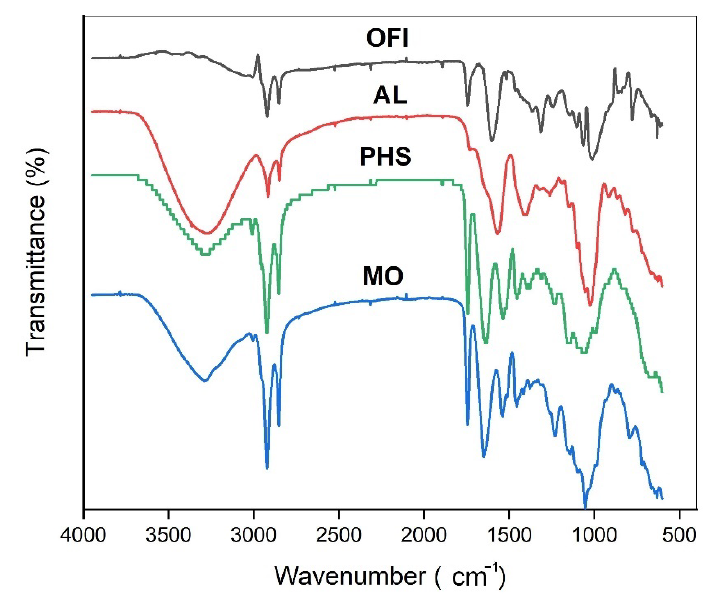
Figure 2. FTIR analysis of the studied bio-coagulants.